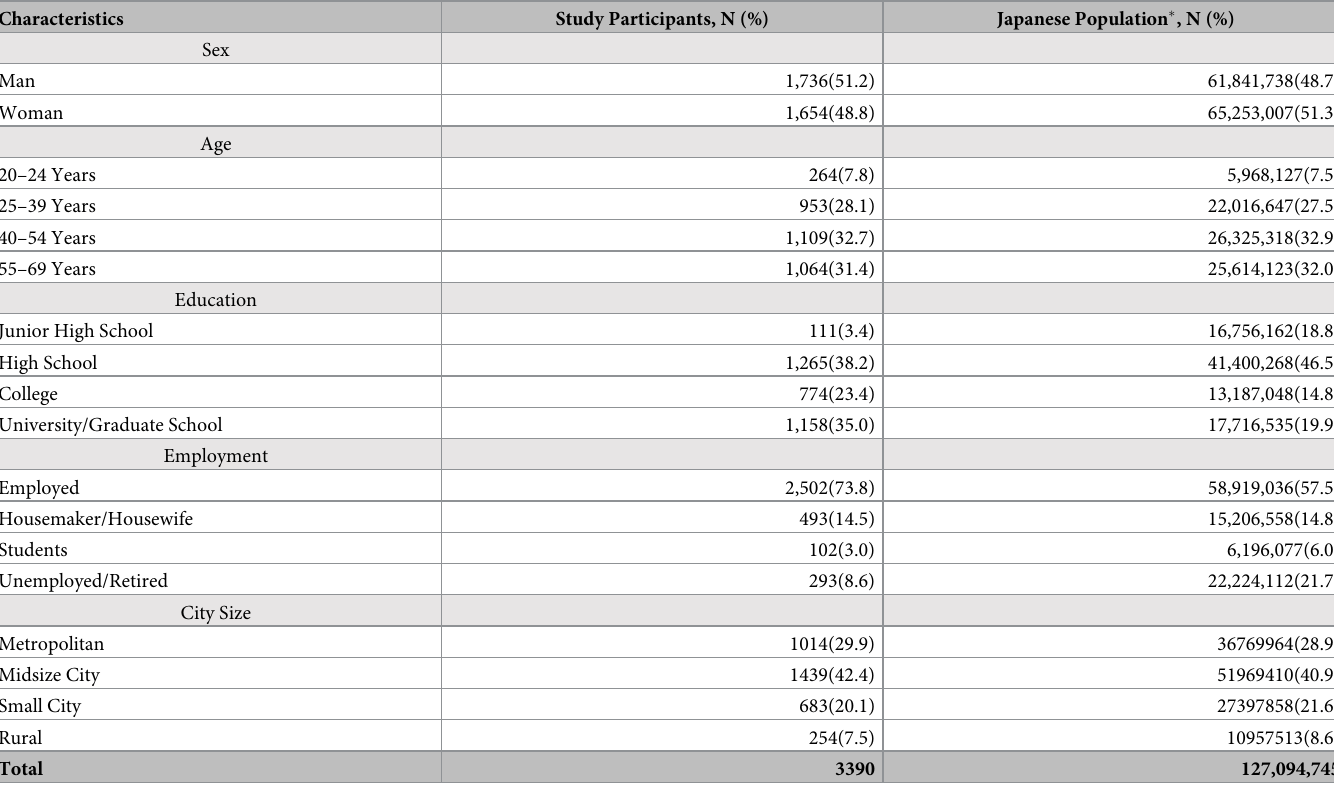
Table 1. Characteristics of participants (N =